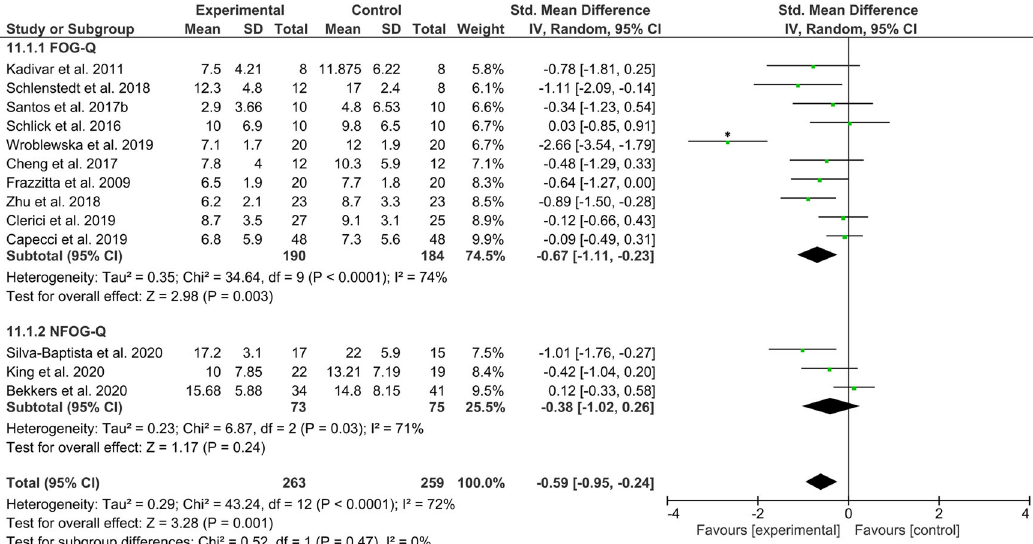
Fig. 8 Secondary analysis comparing effects of category B interventions aimed at the underlying correlates of FOG against any type of control group. The studies are arranged per weight of the study as based on sample size; *signi fi cant outliers removed in the sensitivity